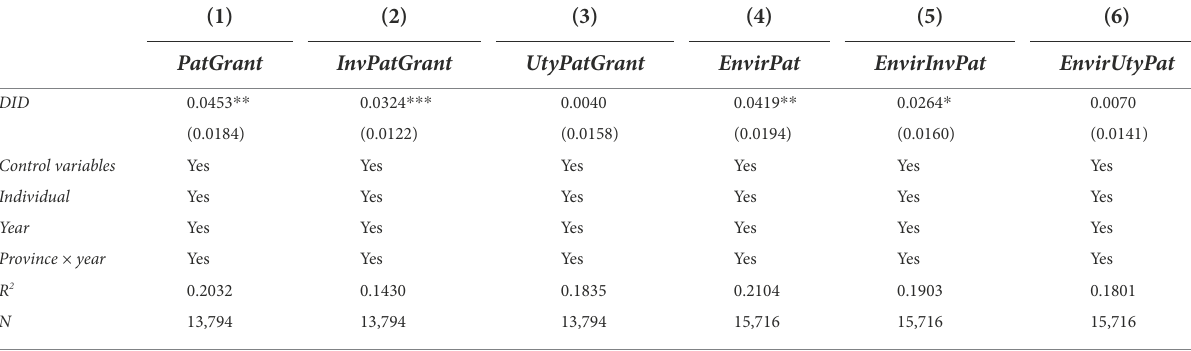
TABLE 3 Robustness tests: replacing core